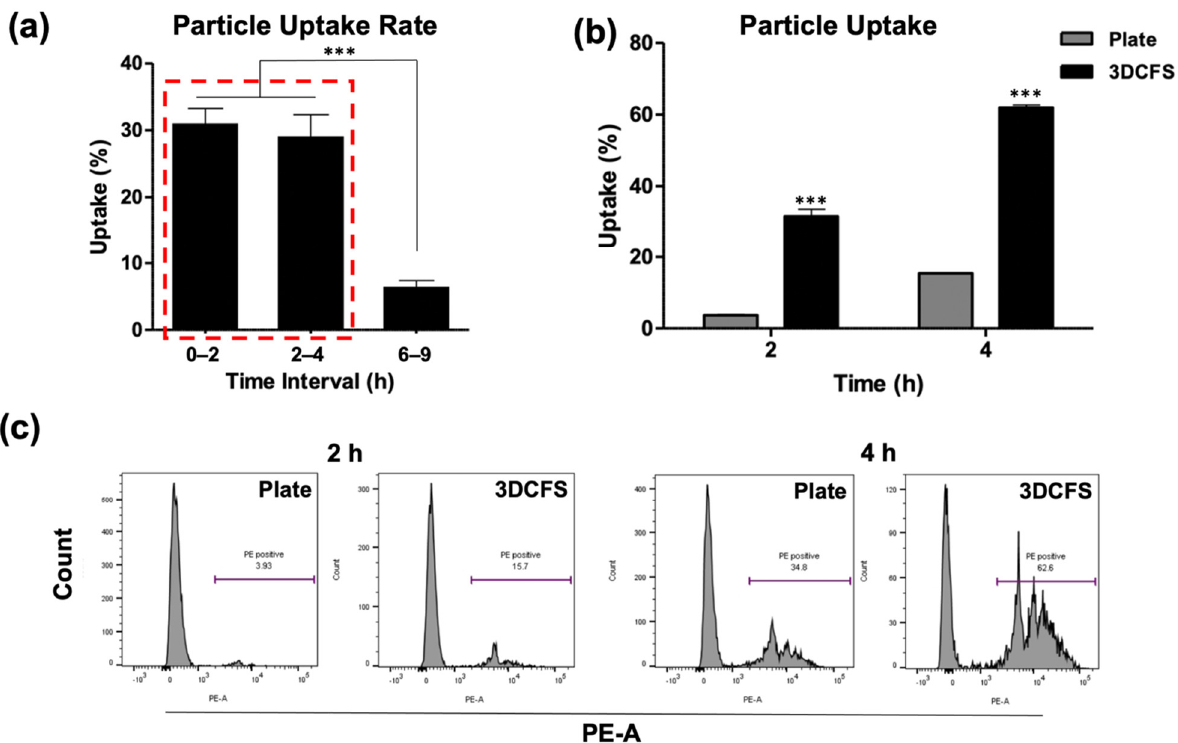
Figure 3. Uptake analysis of A375. A375 cells’ uptake capability was evaluated both when seeded on a plate and floating in the 3DCFS. ( a–c ) 0.8 µm particles were added to the systems and were sampled and analyzed by FACS up to 9 h of incubation. ( a ) Cell particle uptake percentage levels in the 3DCFS during the first 9 h of incubation. Cell particle uptake capability decreased significantly after 6 h compared to the first 4 h (red rectangle). ( b ) Cell particle uptake capability was significantly higher in the 3DCFS compared to the plate after 2 and 4 h of incubation. ( c ) The effect of additional time on the cells’ particle uptake capability was tested. The FACS analysis showed that the cells’ particle uptake capability increased when given more time after 2 h, both on the plate (left) and in the 3DCFS (right). p -value: *** ≤ 0.001.